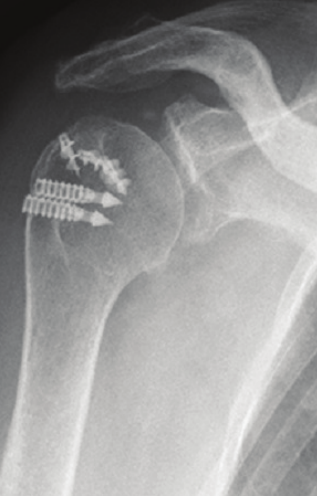
Figure 4: X-ray imaging after arthroscopic rotator cuff repair using a suture bridge